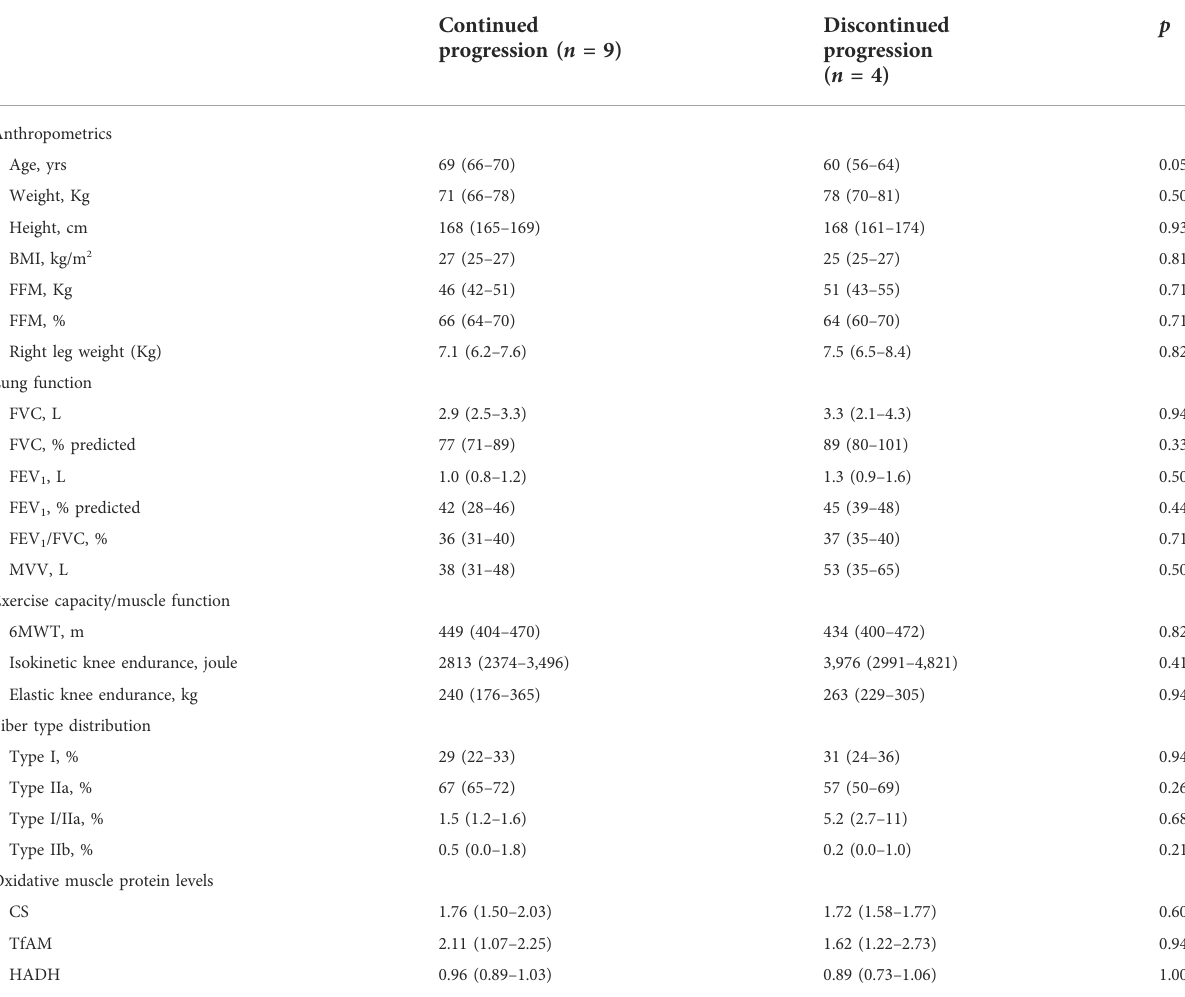
TABLE 1 Patient